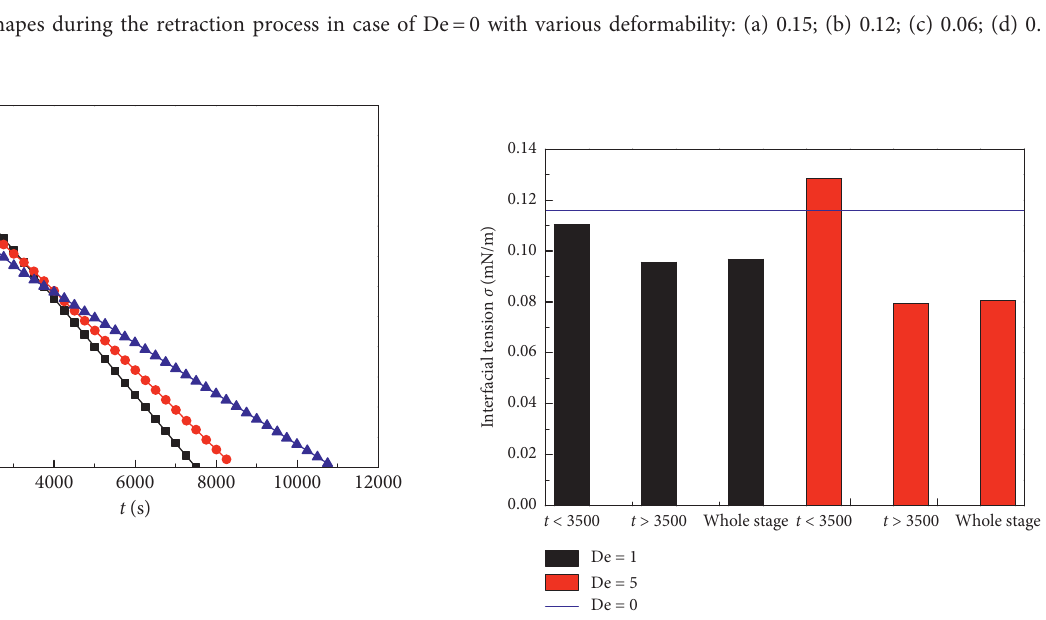
Figure 5: The simulated retraction degree variation with time of different viscoelasticity of the drop with different viscoelasticity (De).